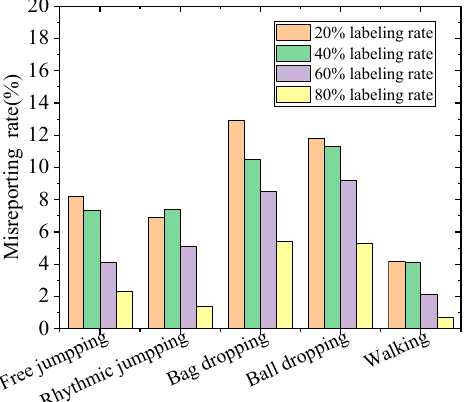
Figure 12. Misreporting rate of SVM-D-R method for non-fall events.